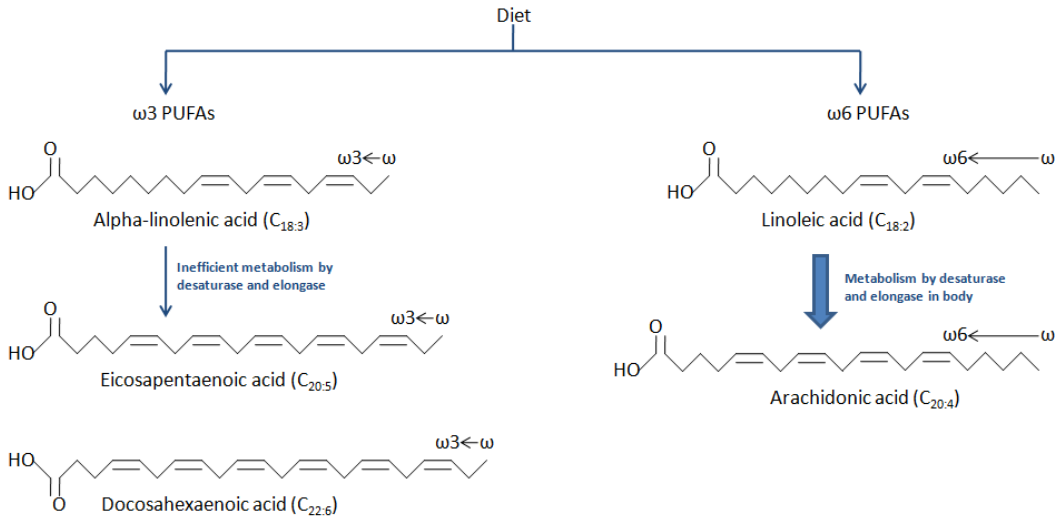
Figure 1. Structure and metabolism of major polyunsaturated fatty acids (PUFAs).